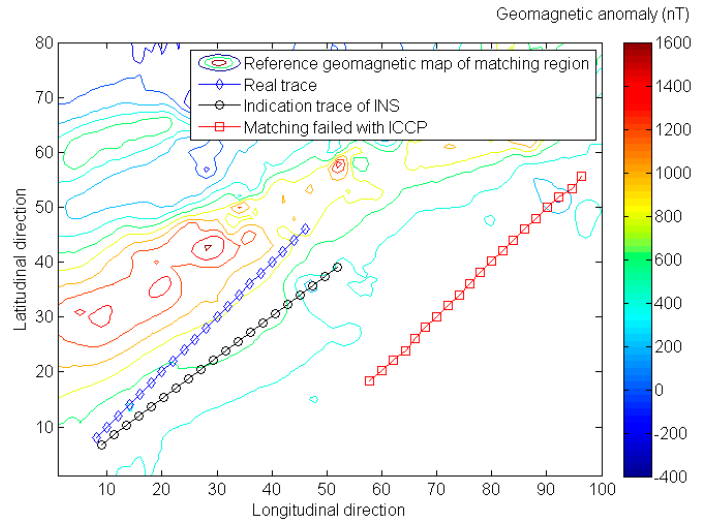
Figure 4. A considerable matching error will generate geomagnetic matching fails.